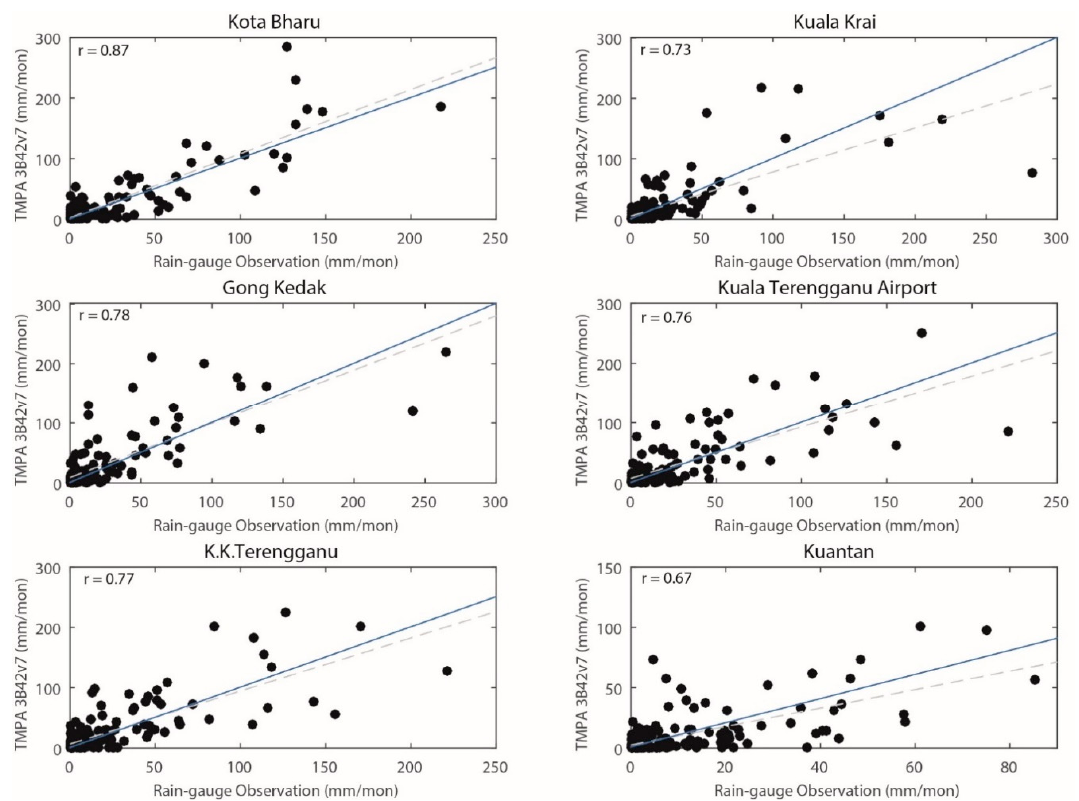
Figure 11. Same as Figure 10, but for TMPA 3B42v7.